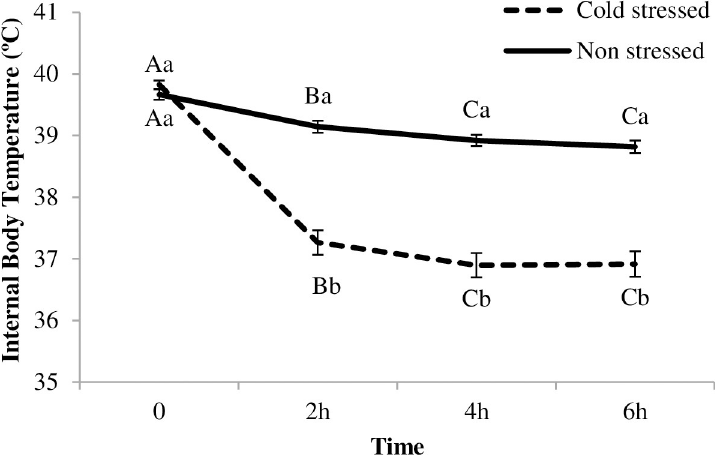
Fig 4. Internal body temperature for Cold Stress (CSTR) No Stress chicks (NSTR). Mean ( ± SE) internal body temperature for acute CSTR and NSTR chicks; temperature was registered in ˚C every 2h, at 0 (beginning of the